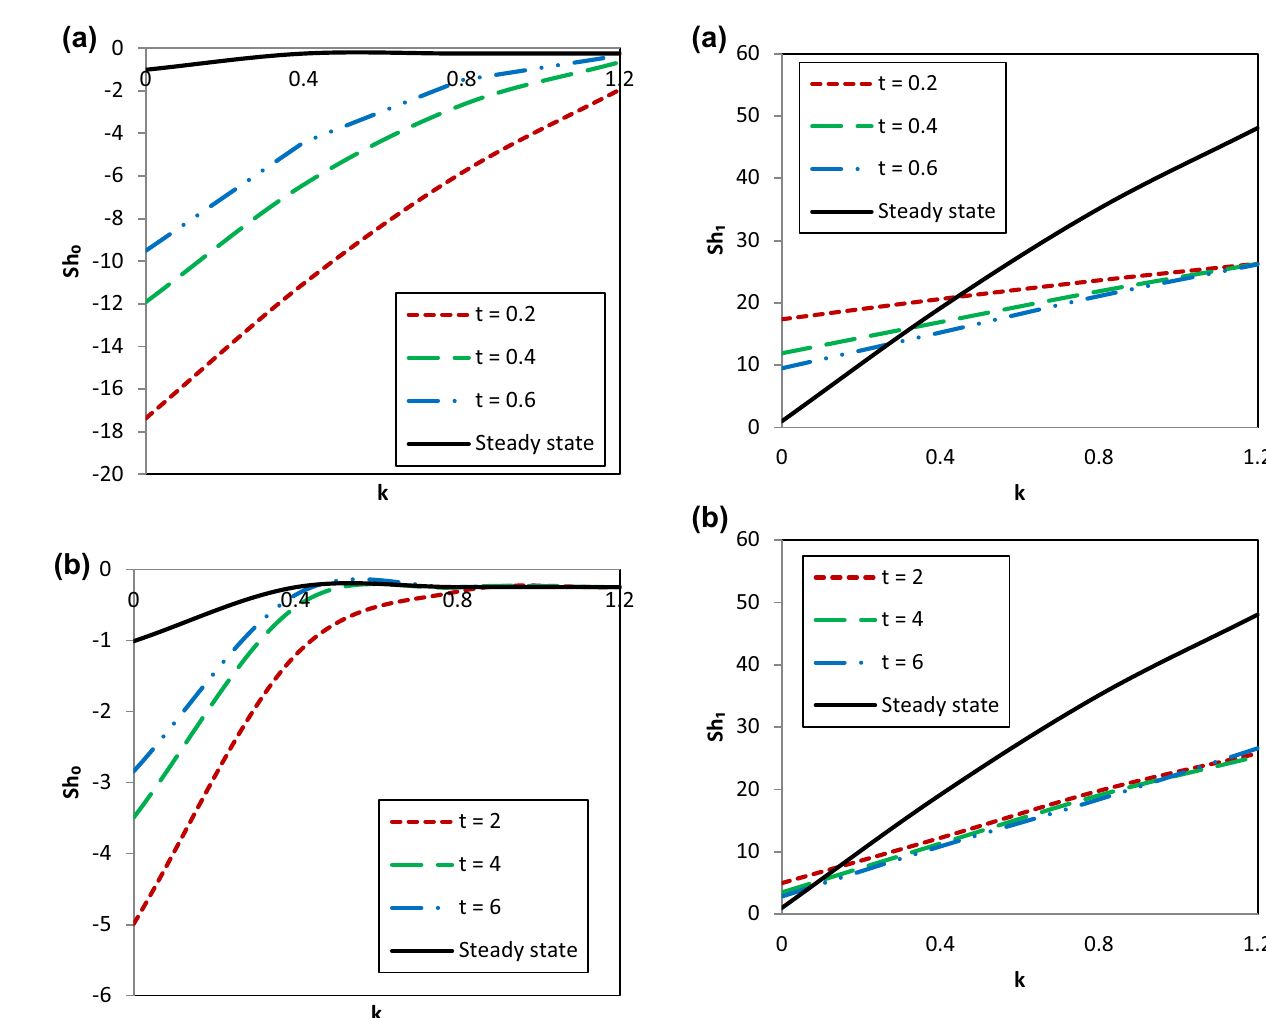
= 2.0, N = 8.0, Bi = Bi = 10 ) . 1 2 c t